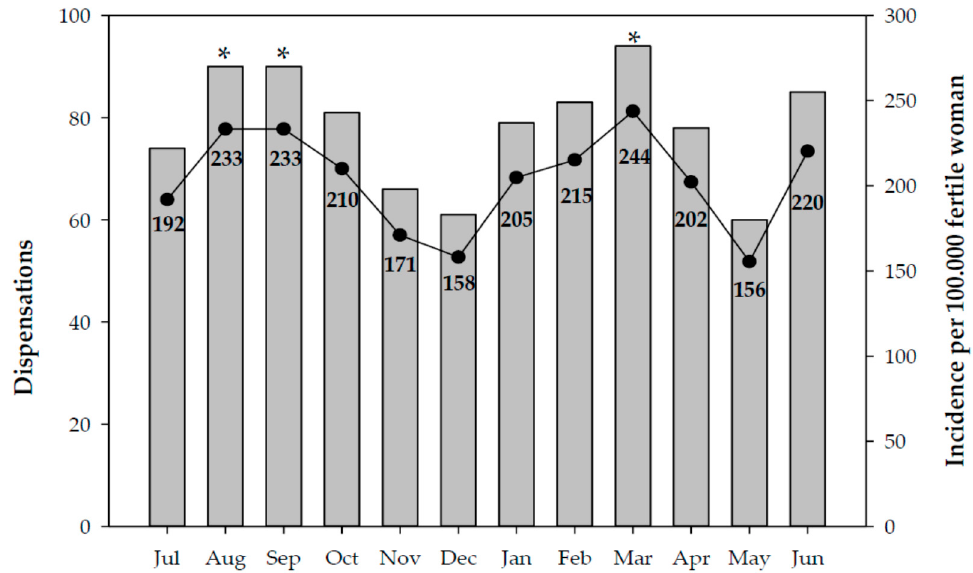
Figure 1. Number of EC dispensations and cumulative incidence per month. Catalonia, 2018–2019. Significant differences: * vs. the incidence in December ( p < 0.05).